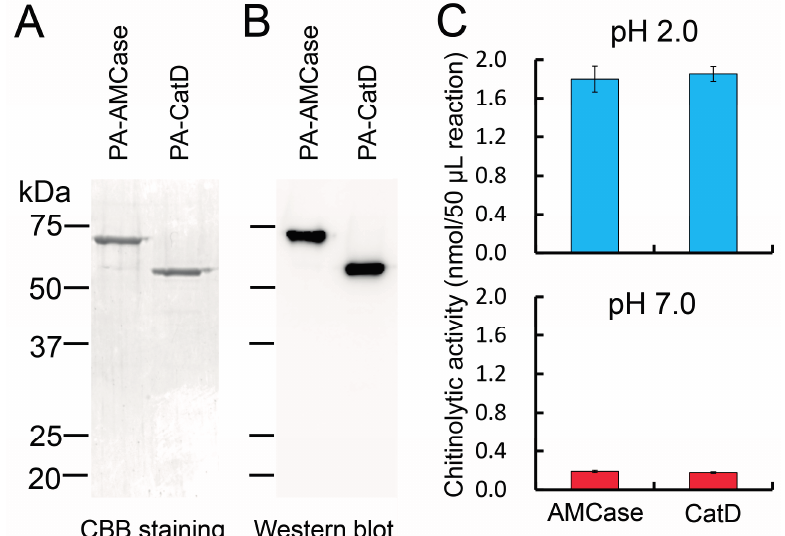
Figure 2. Analysis of the E. coli -expressed fusion proteins. ( A ) 12.5% SDS-PAGE analysis of the recombinant proteins from the periplasmic fractions (Peri 1) of E. coli . The fusion proteins were purified by IgG Sepharose followed by Ni Sepharose chromatography, electrophoresed (1 μ g of protein) and visualized in the gel by Coomassie Brilliant Blue R-250 (CBB); ( B ) Western blot analysis of the recombinant proteins. 0.1 μ g protein separated by SDS-PAGE was transferred to a PVDF membrane. Immunoblot was performed with anti-V5-HRP antibody. PA-AMCase, Protein A-AMCase-V5-His; PA-CatD, Protein full-length AMCase in 50 μ L reactions using 0.1 M Gly-HCl buffer (pH 2.0) or